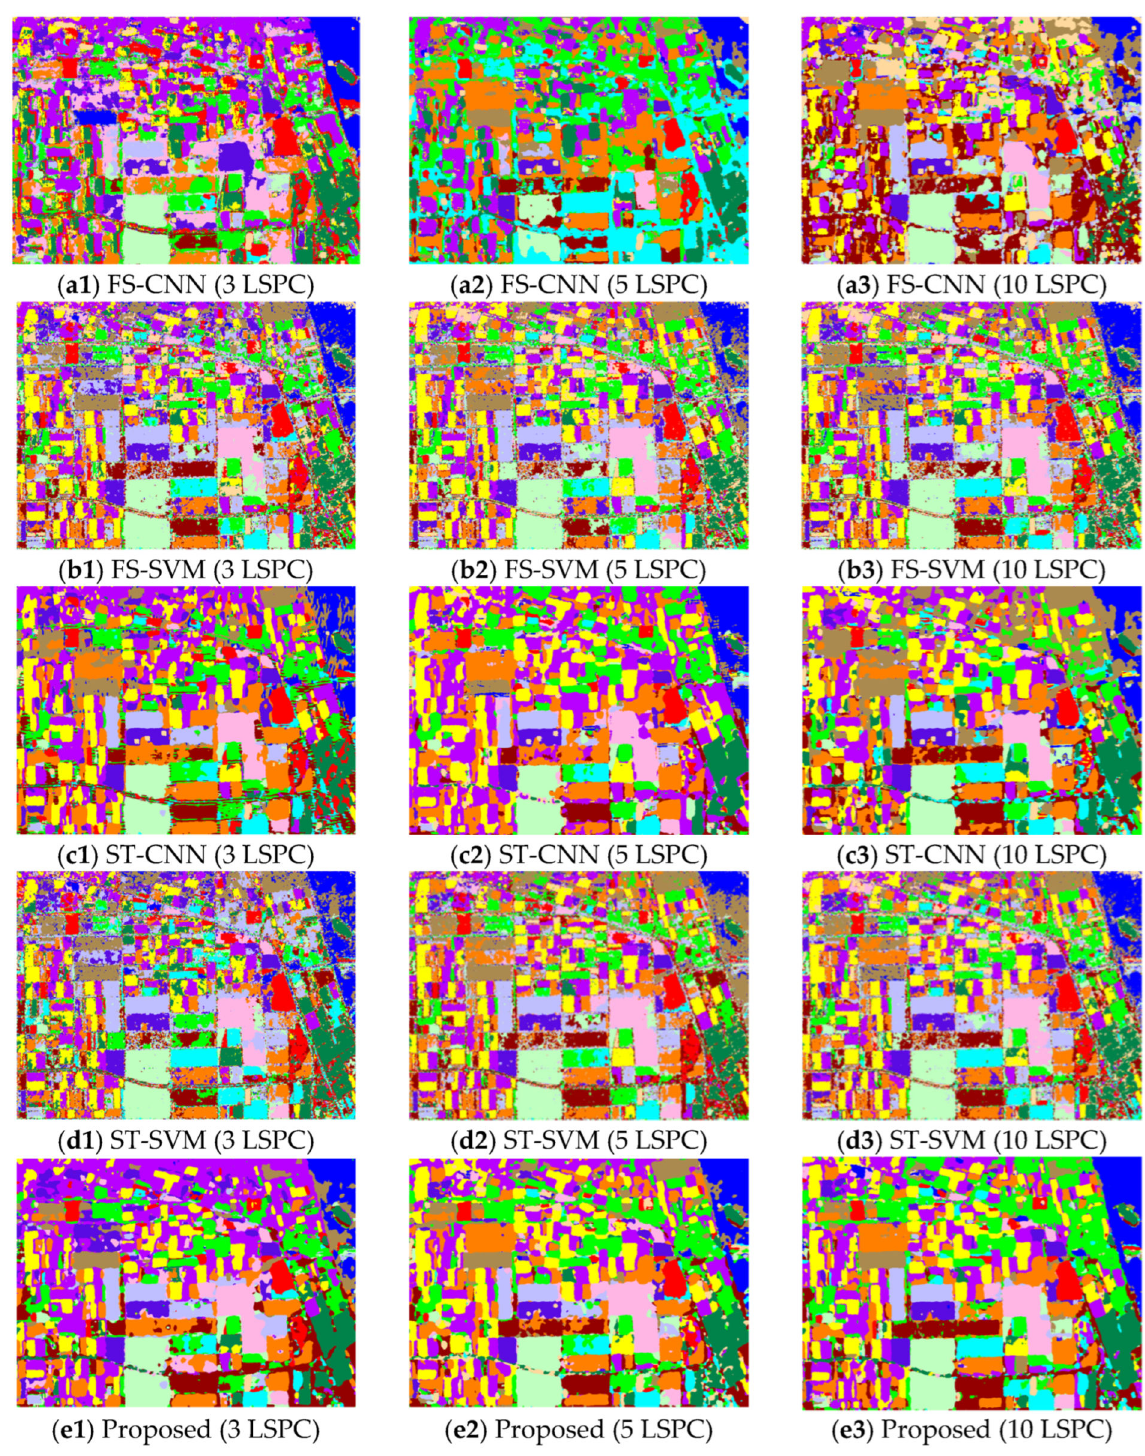
Figure 8. Classification maps of dataset 1 given by five methods with different sample sizes. The maps from up to down are given by FS-CNN, FS-SVM, ST-CNN, ST-SVM and the proposed methods, respectively, and those from left to right have 3, 5, and 10 LSPCs,